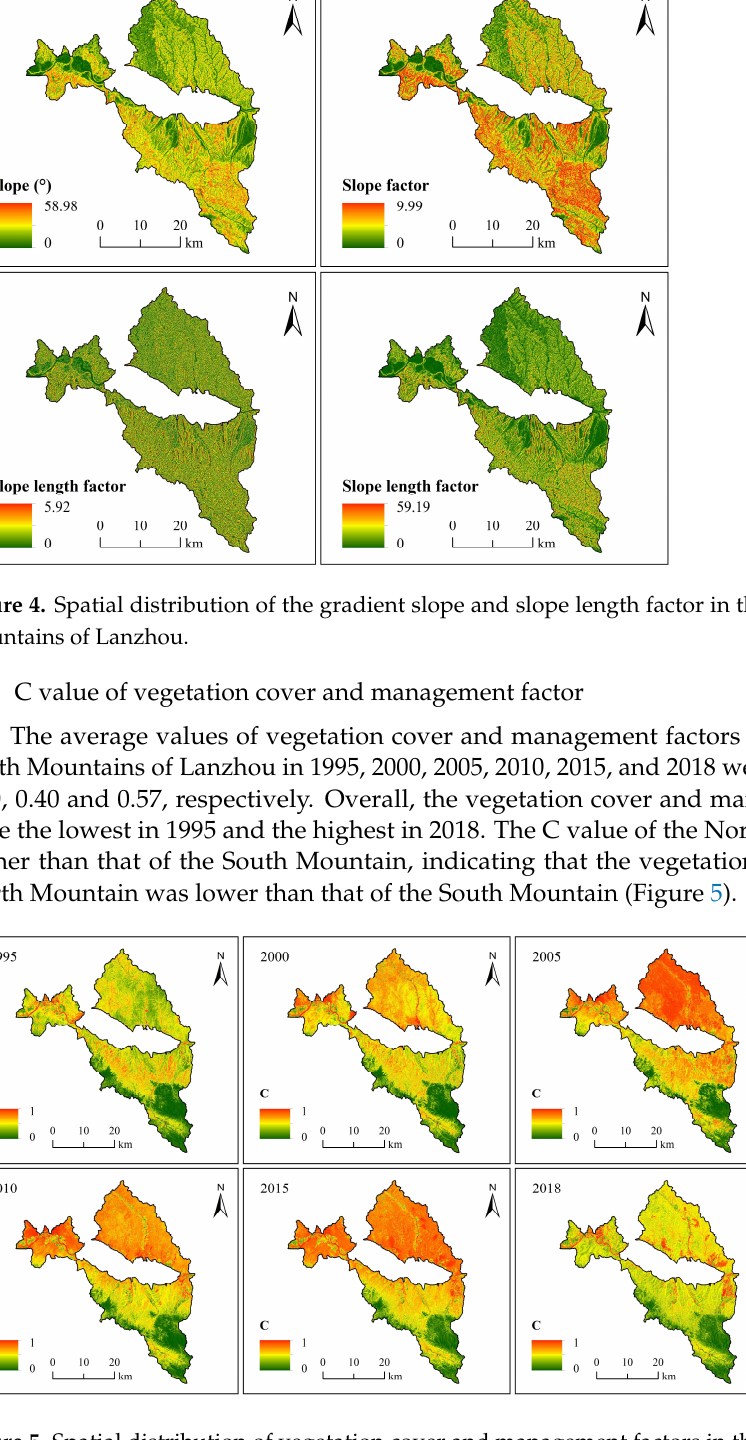
Figure 3. Spatial distribution of soil erodibility factor K in the South and North Mountains of Lan- zhou.